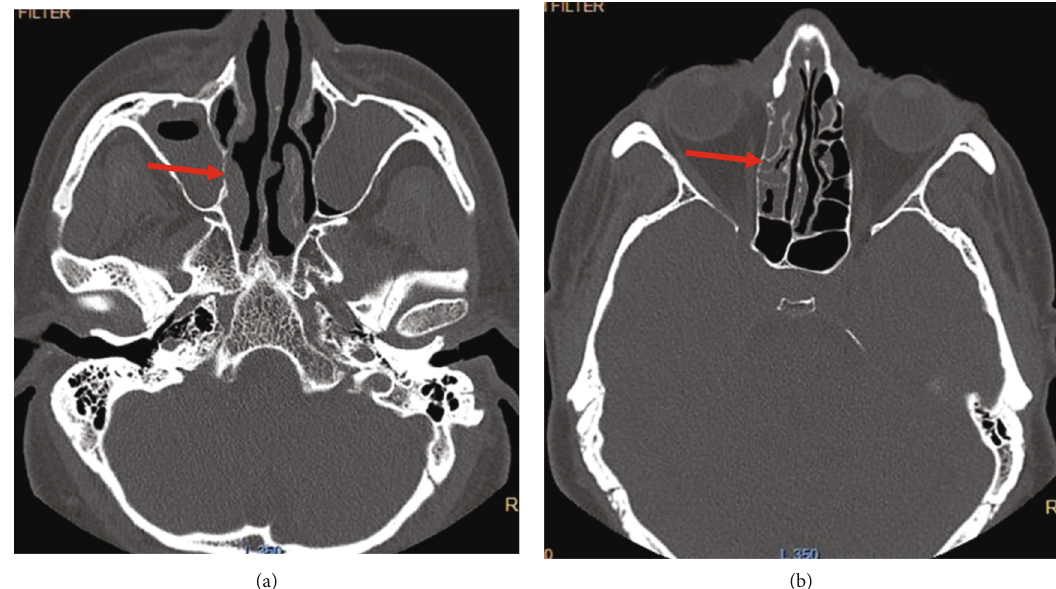
Figure 4: Axial paranasal CT images without contrast administration showing (a) mucosal thickening and secretion in the right maxillary sinus and a retention cyst in the Lt maxillary sinus and (b) mucosal thickening and secretion in the right ethmoid sinus with a lesser degree in the Lt ethmoid sinus.